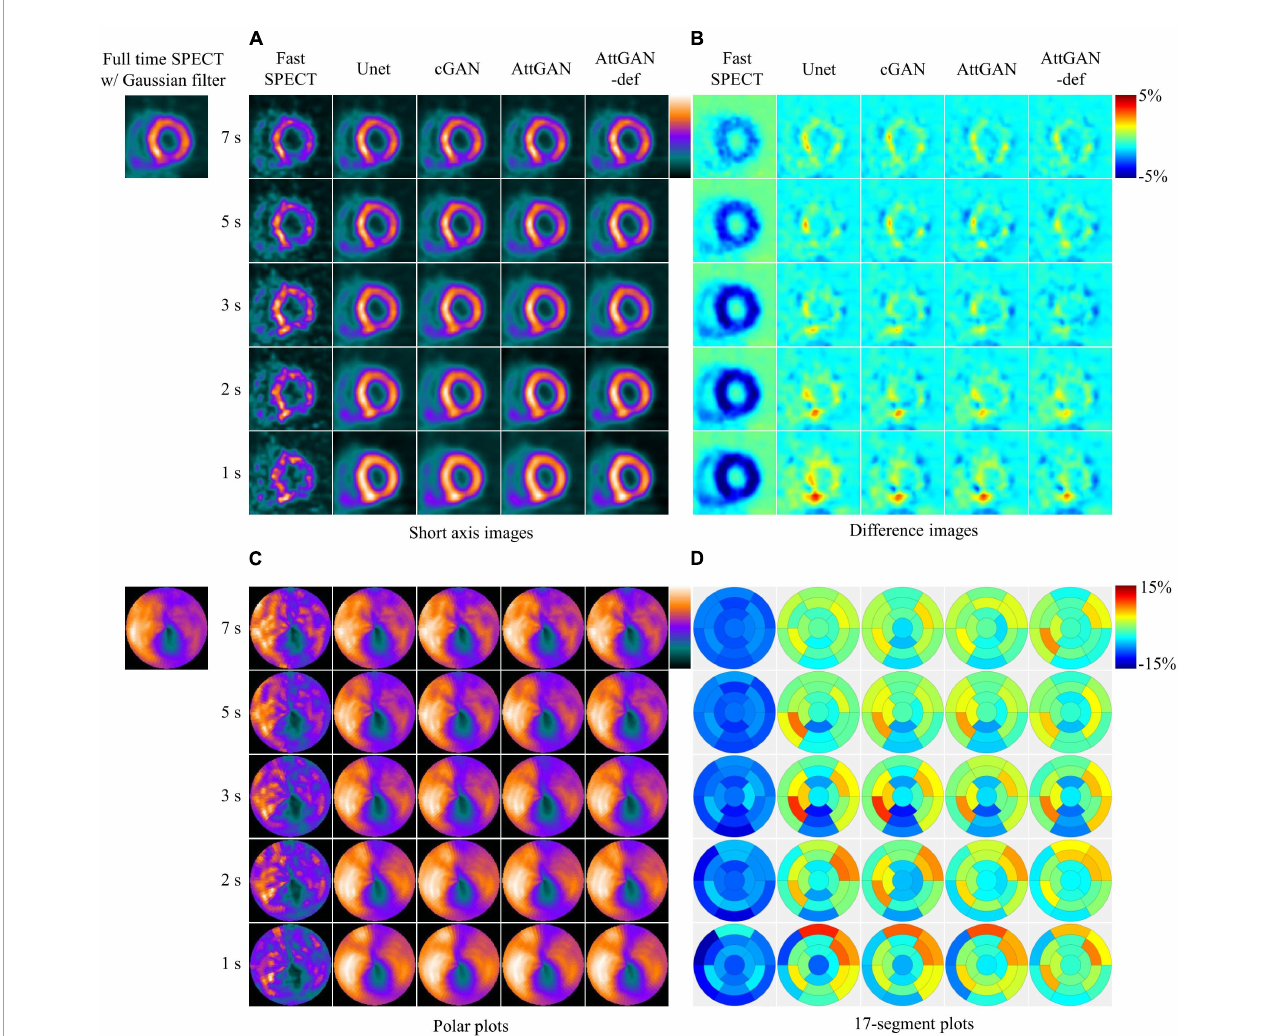
FIGURE5 Sample images of another male patient (age = 77, BMI = 24.2) with an abnormal perfusion in the LAD and LCX territory before and after DL-based denoising for five shorter acquisition times. The images are shown in (A) short axis images, (B) difference images, (C) polar plots, and (D) 17-segment